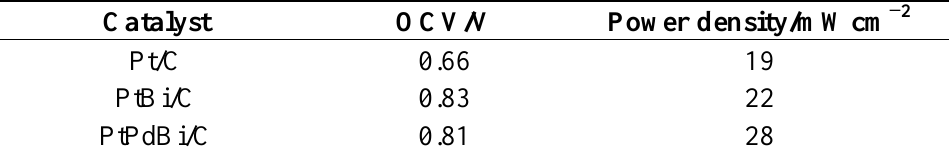
Table 2. Fuel cell performance using ethylene glycol in alkaline medium at multi-metallic Pt based catalysts